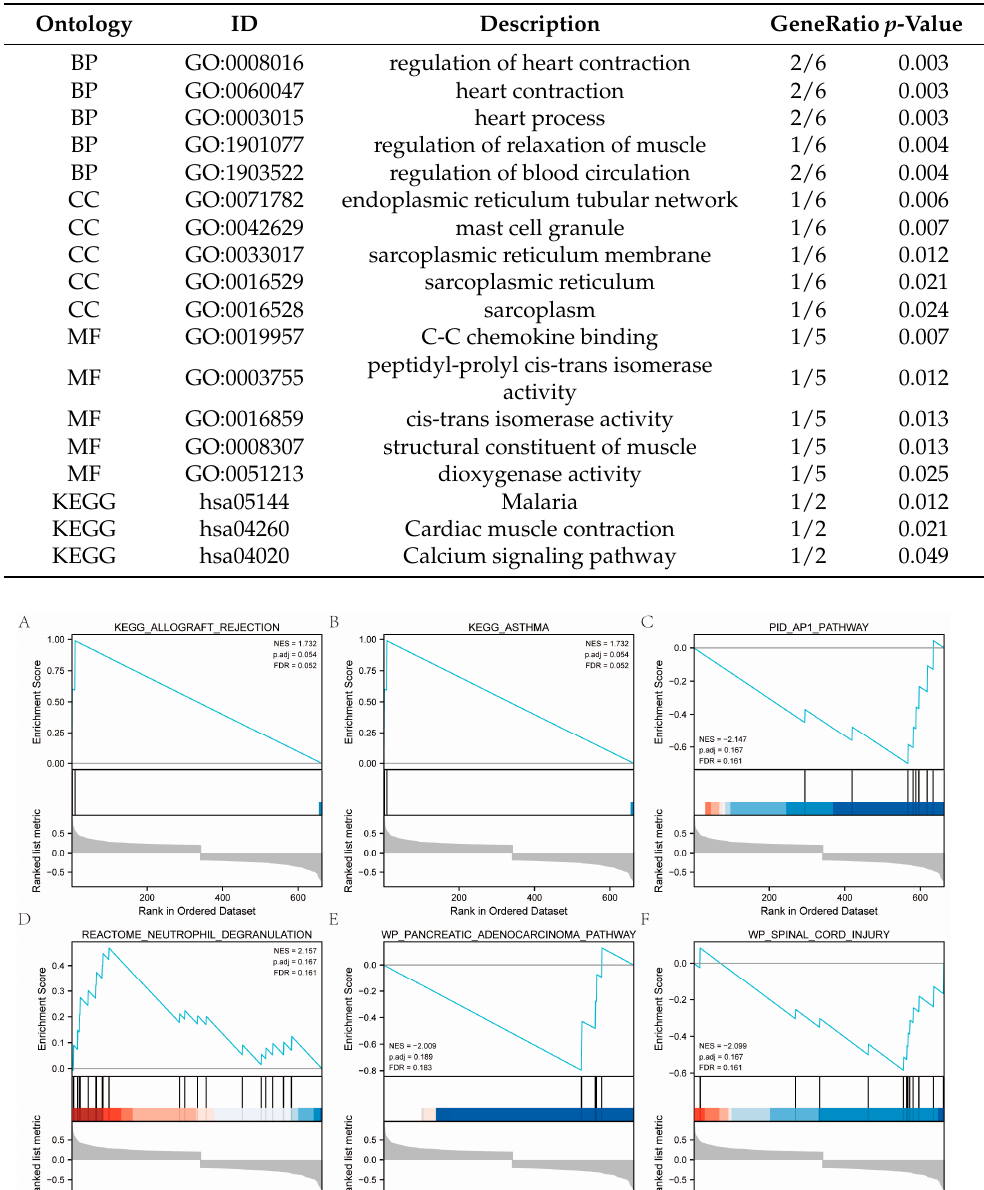
Table 1. GO/KEGG analysis.